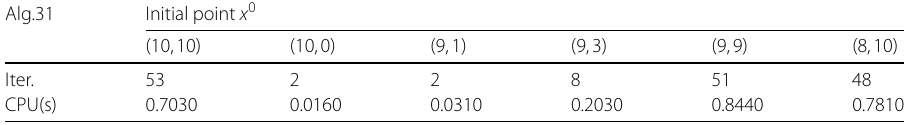
Table 2 Numerical results for Example